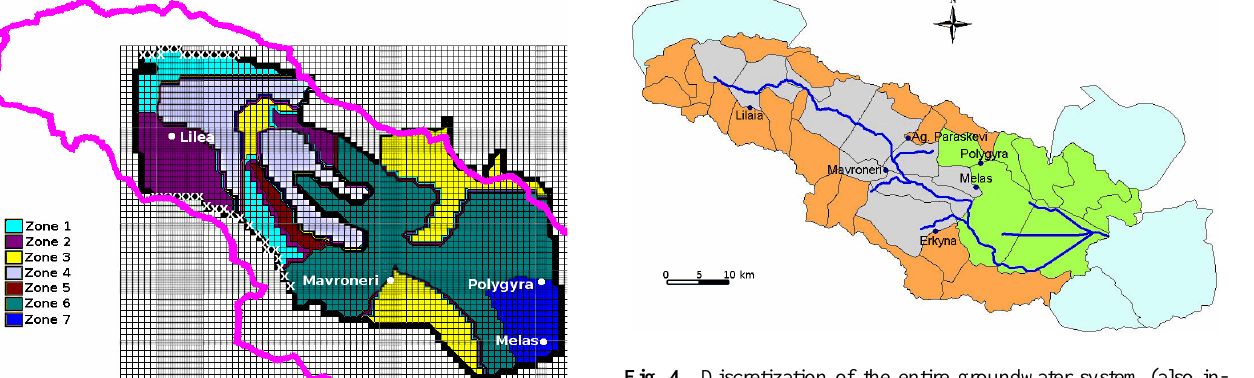
Fig. 4. Discretization of the entire groundwater system (also in- dicating the springs and the four dummy cells, accounting for un- derground losses) and zonation approach (three zones in different colours), according to modelling framework